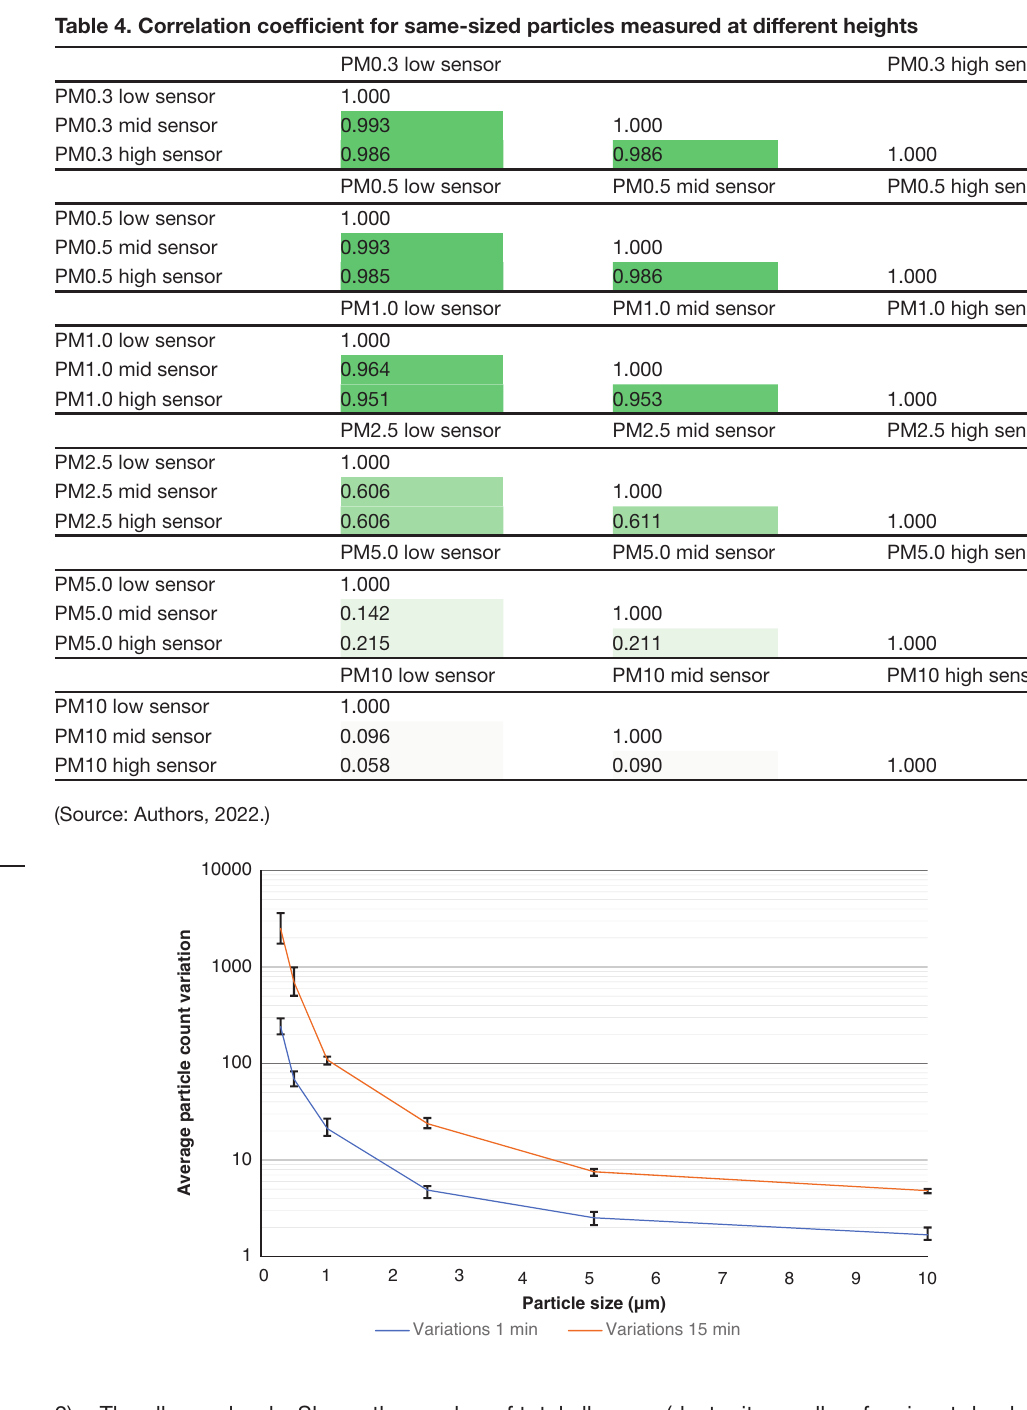
Table 4. Correlation coefficient for same-sized particles measured at different heights